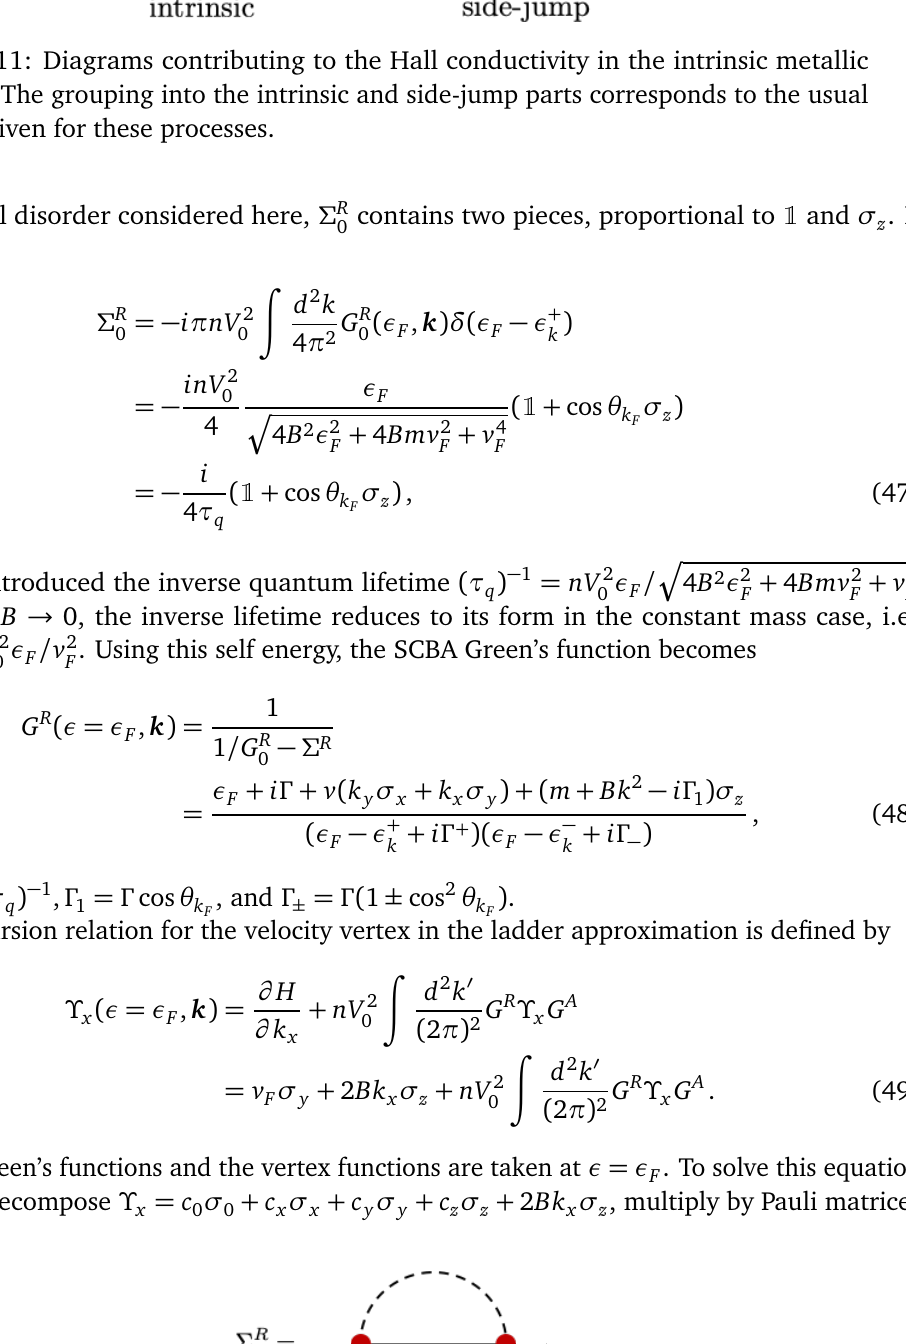
Figure 12: The diagram is constituting the lowest order contribution to the quasipar- ticle